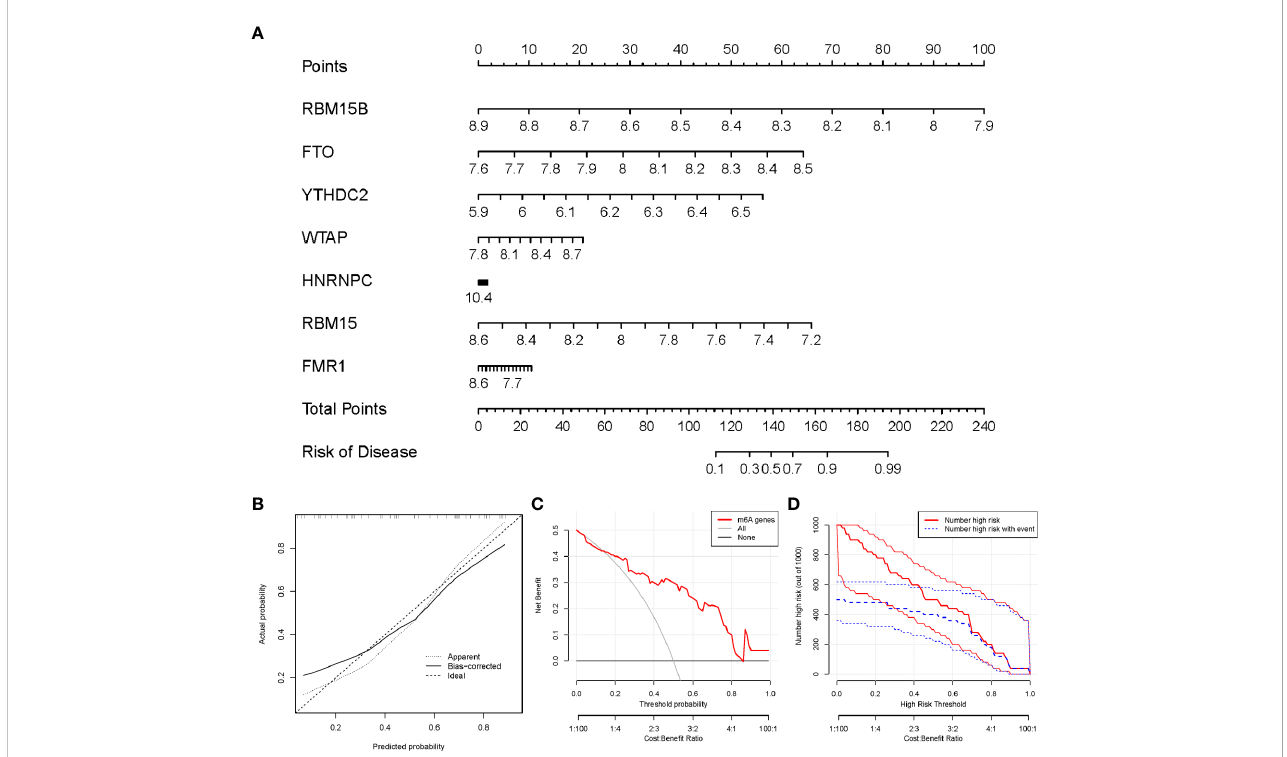
FIGURE 5 Establishment of the nomogram model. (A) The nomogram model was established on the basis of the 7 candidate m6A modulators. (B) The calibration curve was utilized to evaluate the predictive accuracy of the nomogram model. (C) Decisions on the basis of this nomogram model may be bene fi cial to PMOP patients. (D) The clinical impact curve was used to assess clinical impact of the nomogram